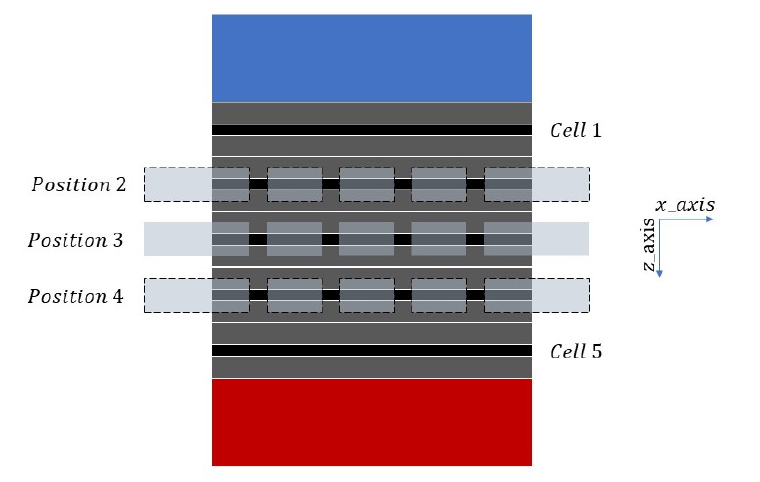
Figure 6. Different analyzer positions across